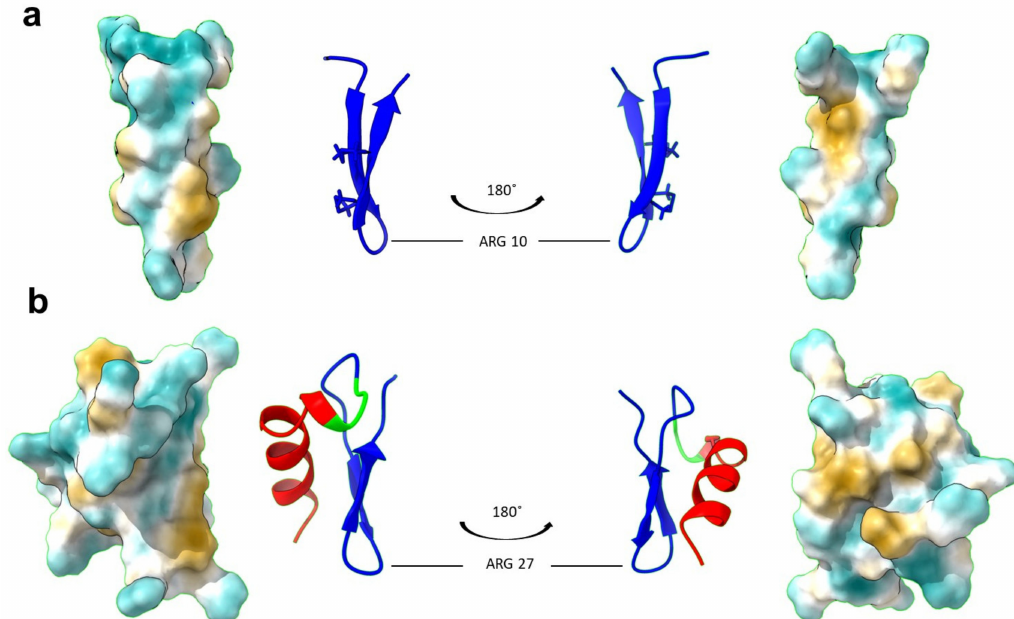
Figure 1. Refined 3D structure of the PG-1 and SynPG-1, generated using ChimeraX. ( a ) The 3D structure of PG-1 was obtained from the Protein Data Bank (PDB ID: 1PG1). Shown here are the front and back views of the secondary structure with disulfide bonds displayed, as well as the prediction of the hydrophobicity profile of the peptide surface, where blue indicates most hydrophilic regions and yellow indicates most hydrophobic regions. ( b ) The 3D structure of SynPG-1 was predicted using iterative threading ASSEmbly refinement (I-TASSER). Shown here are the front and back views of the secondary structure, with the Syn domain in red, the linker region in green, and the PG-1 domain in blue, as well as the prediction of the hydrophobicity profile of the peptide surface, where blue indicates most hydrophilic regions and yellow indicates most hydrophobic